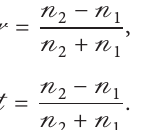
Figure 2: Reflection and transmission of light at an interface.